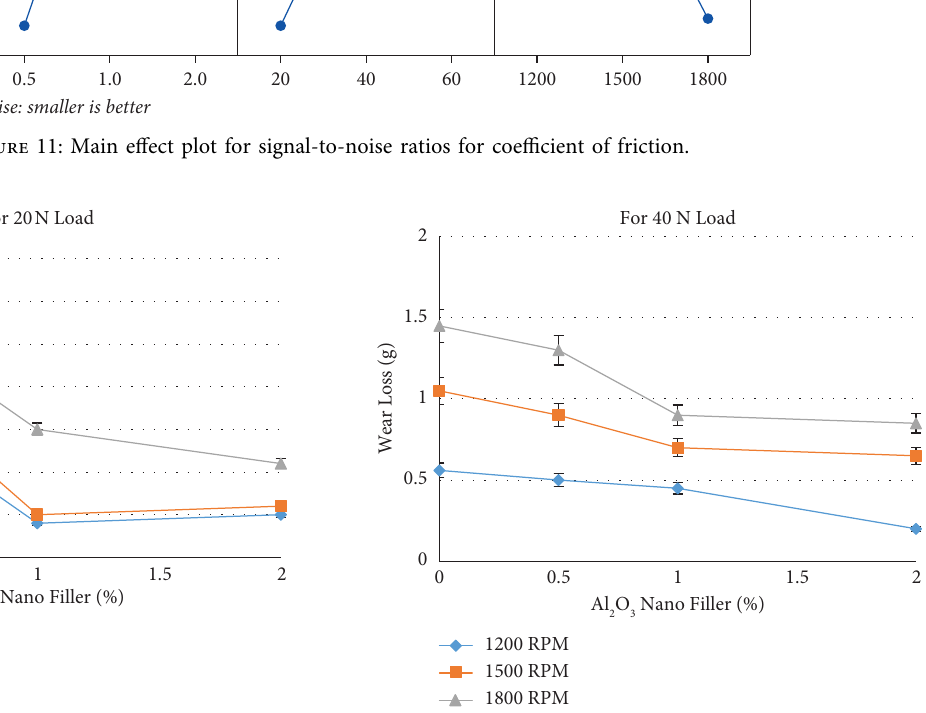
13: Wear loss of epoxy hybrid composites at 40N